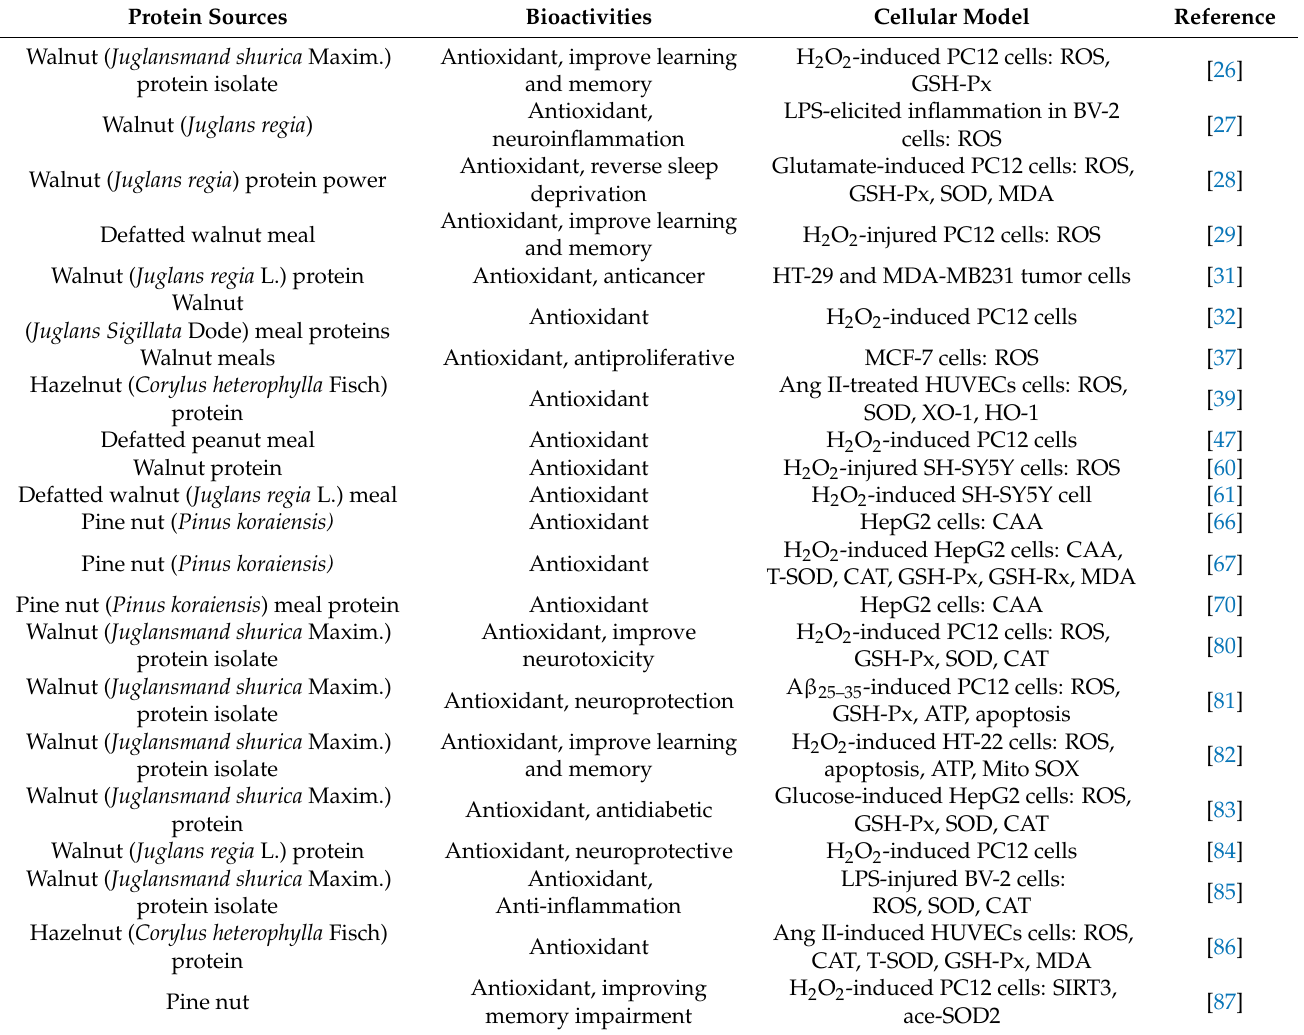
Table 4. Evaluation of antioxidant activity of nut-derived peptides by cellular